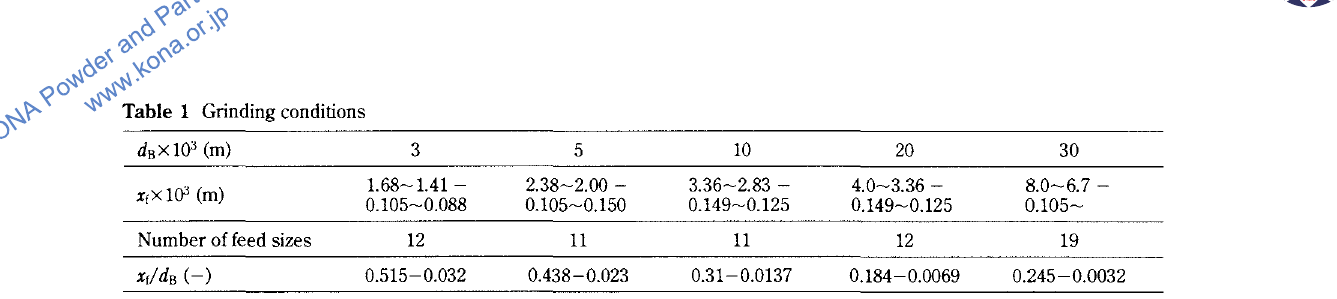
Figs. 1 through 3 show examples of the relation-